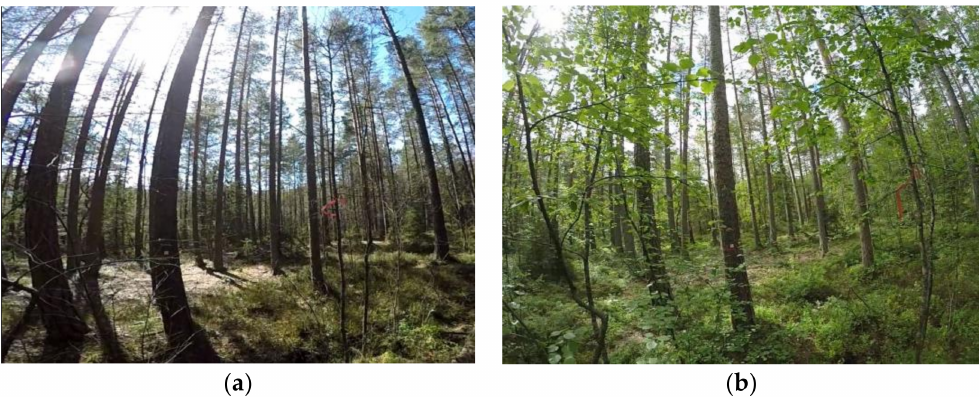
Figure 4. ( a ) Understory vegetation in May 2017. ( b ) Understory vegetation in July 2017 at the same location as ( a ).